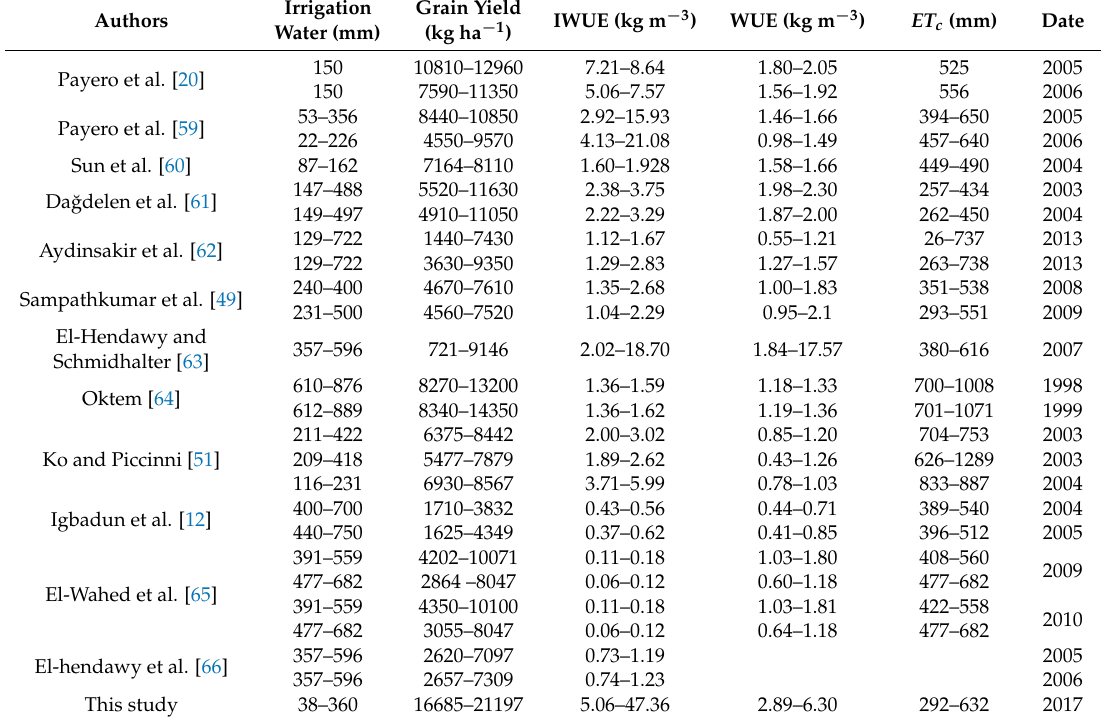
Table 8. The comparisons of grain yield, IWUE, WUE, and ET c of maize under different irrigation strategies in previous studies compared to this